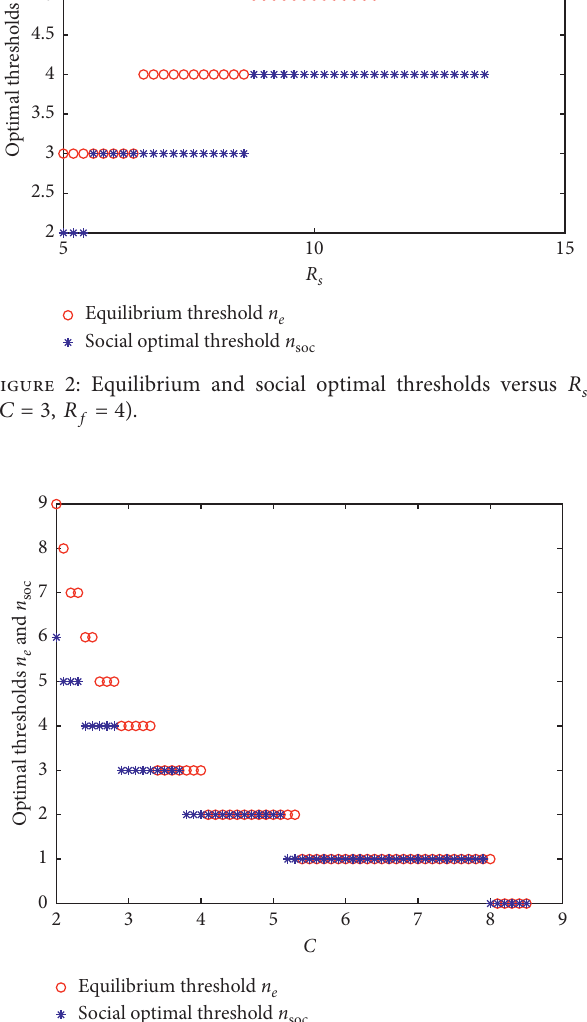
Figure 3: Equilibrium and social optimal thresholds versus C � 8 , R � 4 ) . ( R s f